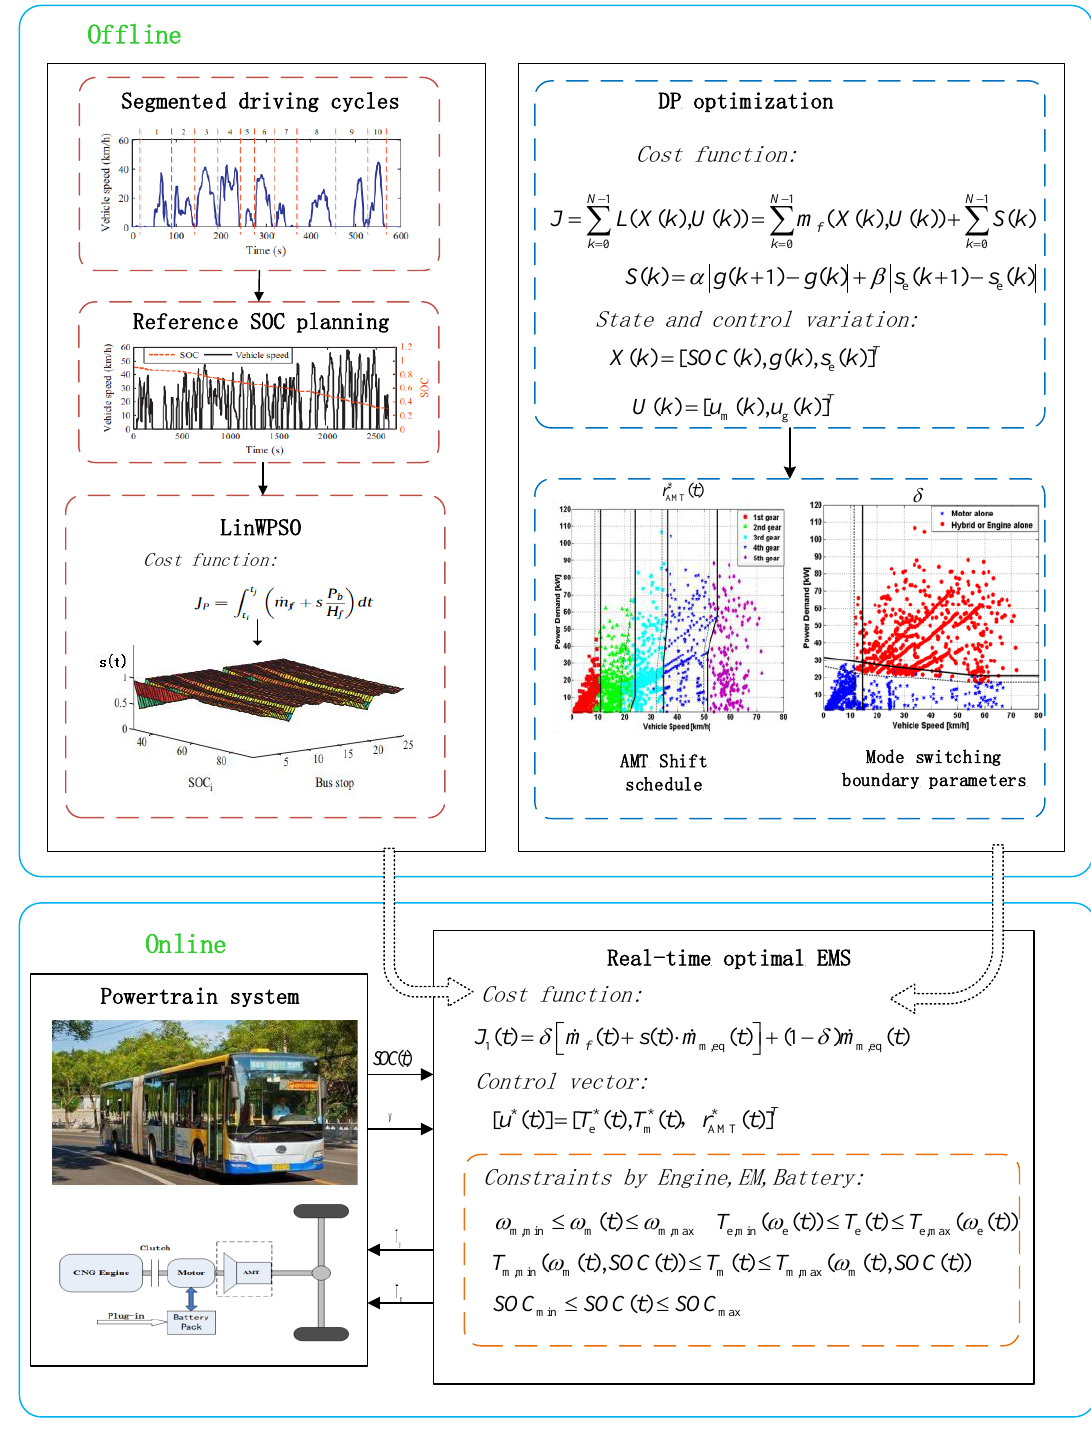
Figure 6. Control scheme of the proposed strategy.